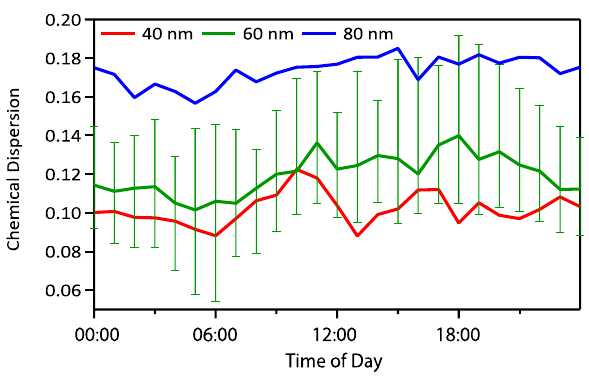
Fig. 8. Diurnal variation of σ ( κ ) for 40, 60, and 80nm particles.